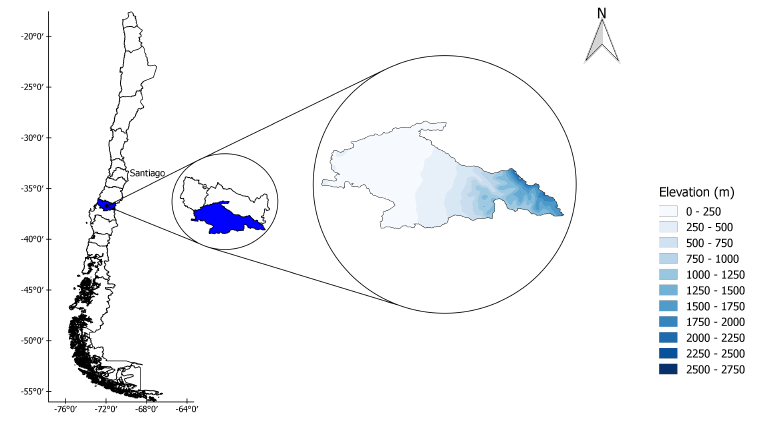
Figure 2. Study area